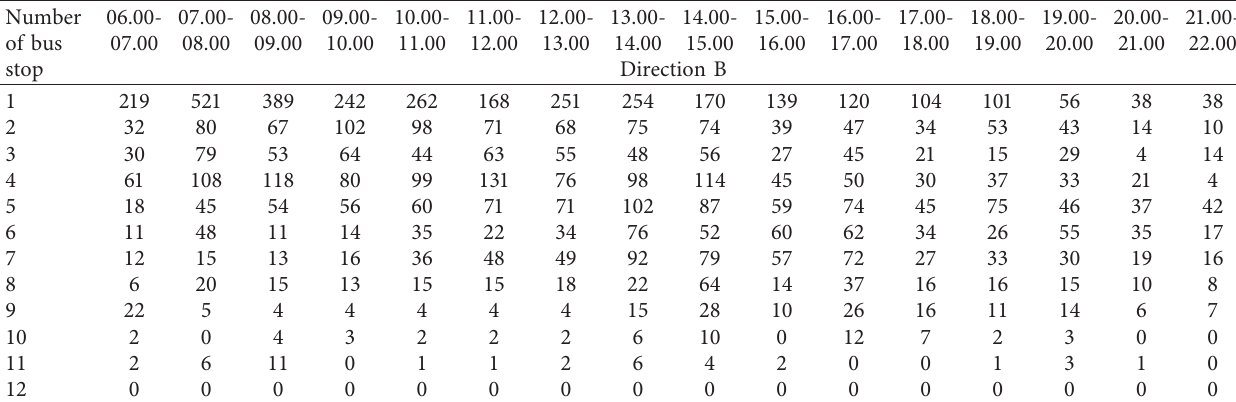
Table 4: Hour distribution of entries by bus stops, observed in direction